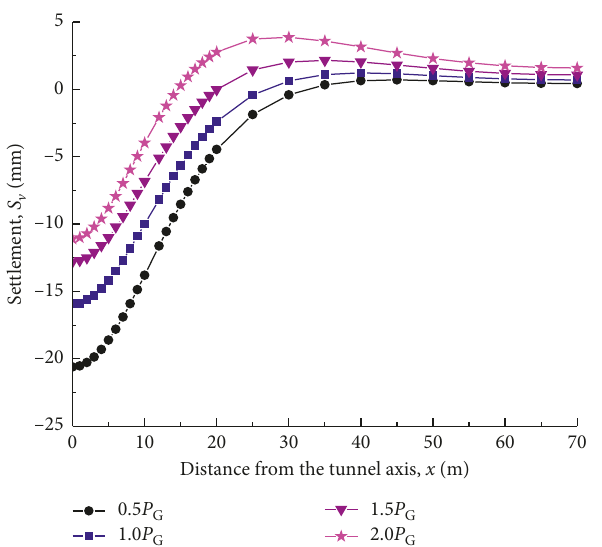
Figure 20: Transverse surface settlement profiles for four different grouting pressures.